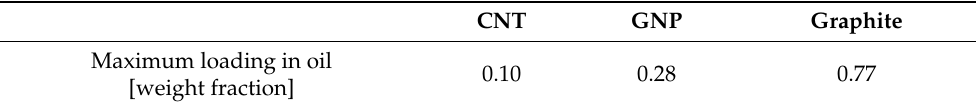
Table 2. Maximum loading of the different fillers in the oil